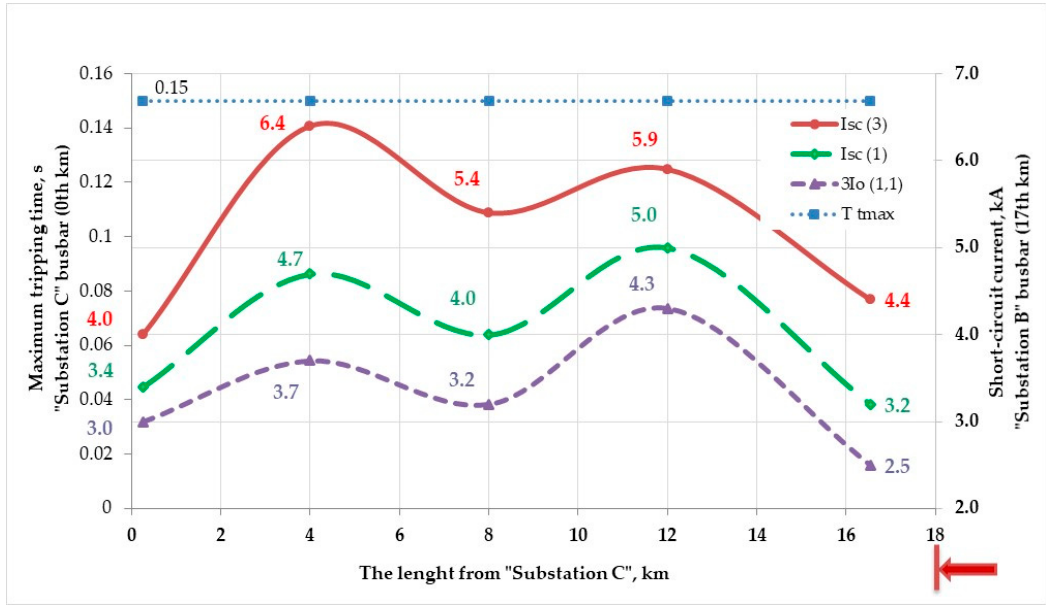
Figure 5. Estimated short-circuit currents along 110 kV “OHL No.2” from “Substation B” (17th km) toward “Substation C” (zeroth km).